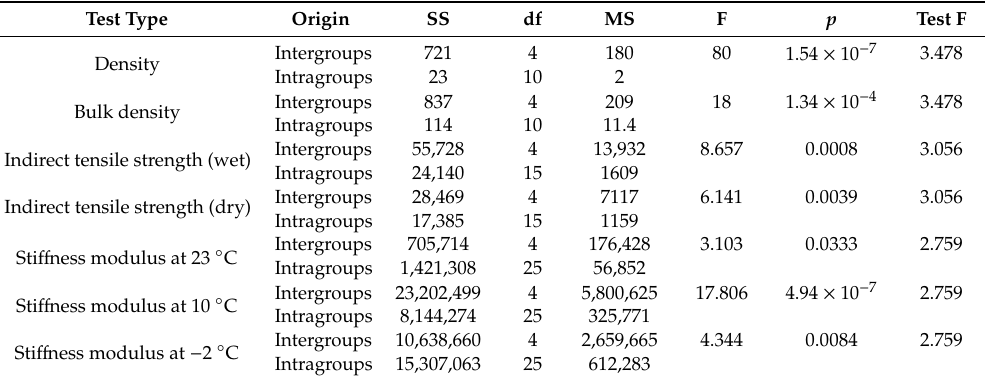
Table 5. Analysis of variance (ANOVA) analysis on the particular